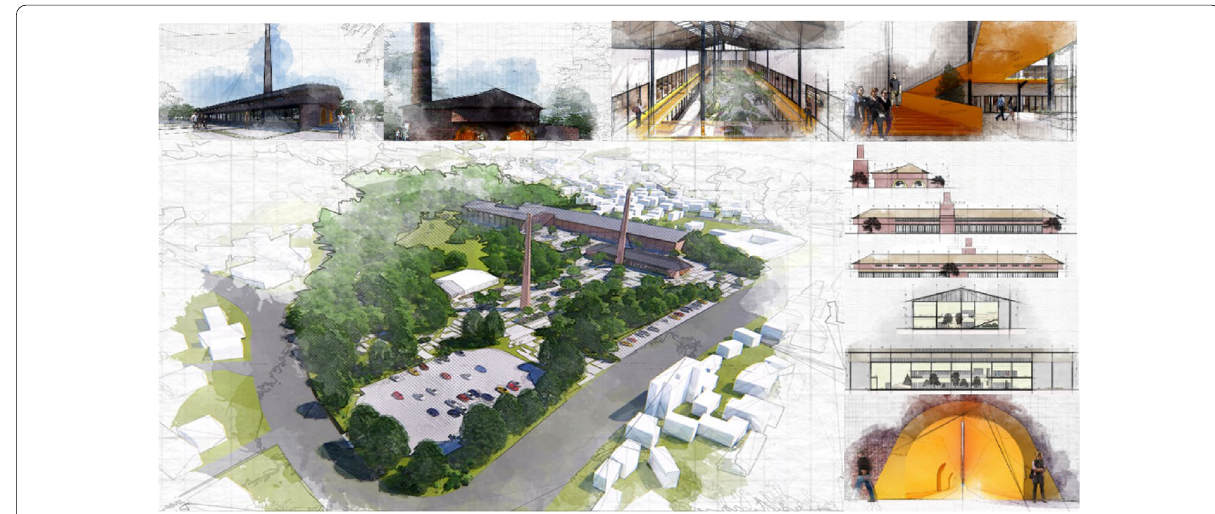
Fig. 5 Brick Factory architectural design proposal (author: